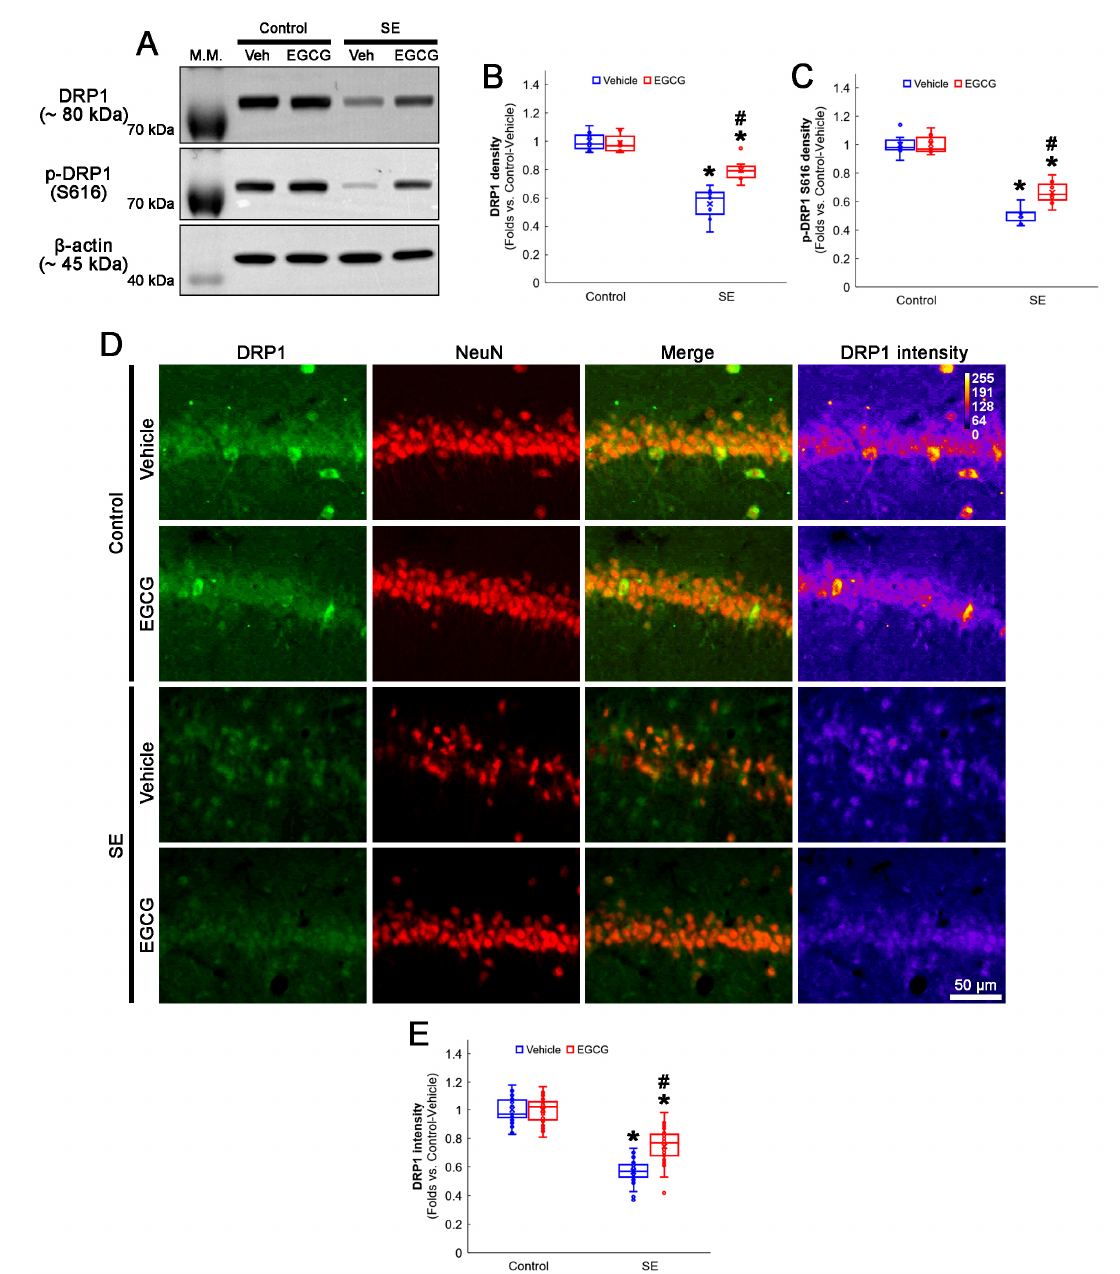
Figure 5. Effects of EGCG on DRP1 and its S616 phosphorylation following SE. Western blot data showed that DRP1 expression and its S616 phosphorylation decreased in SE group, compared with control animals. In control animals, EGCG did not affect DRP1 expression and its S616 phosphorylation level. EGCG attenuated a decrease in DRP1 expression and its S616 phosphorylation in SE group ( A – C ). Immunofluorescent study also revealed that DRP1 expression was reduced in CA1 neurons of SE group, compared with control animals. In control animals, EGCG did not affect DRP1 expression in CA1 neurons. EGCG attenuated a decrease in DRP1 expression in CA1 neurons of SE group ( D , E ). ( A ) Representative Western blot of DRP1 and its S616 phosphorylation in the whole hippocampus. ( B ) Quantification of DRP1 protein level based on Western blot data (* and # p < 0.05 vs. control and vehicle-treated rats; n = 7 rats, respectively). ( C ) Quantification of DRP1 S616 level based on Western blot data (* and # p < 0.05 vs. control and vehicle-treated rats; n = 7 rats, respectively). ( D ) Representative photos of DRP1 expression and its intensity. ( E ) Quantification of DRP1 intensity in CA1 neurons (* and # p < 0.05 vs. control and vehicle-treated animals; n = 35 cells in 7 rats,